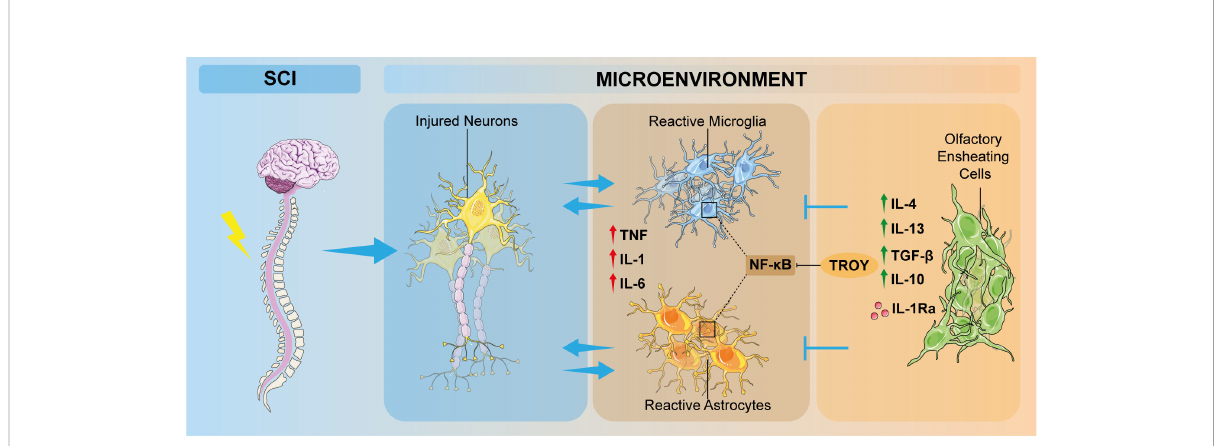
FIGURE 2 Schematic overview of the involvement of OECs in in fl ammation modulation after SCI. Neuronal damage induces pathological increasing of in fl ammatory responses, which promotes microglia polarization from a resting state to a M1-phenotype and astrocyte activation. OECs are able to modulate these in fl ammatory events by interacting directly or indirectly with microglia and astrocytes, thus ameliorating the detrimental condition of the altered microenvironment. OEC, olfactory ensheathing cell; SCI, spinal cord injury; TNF, tumor necrosis factor; IL, interleukin; TGF- b , transforming growth factor b , IL-1Ra: interleukin-1 receptor